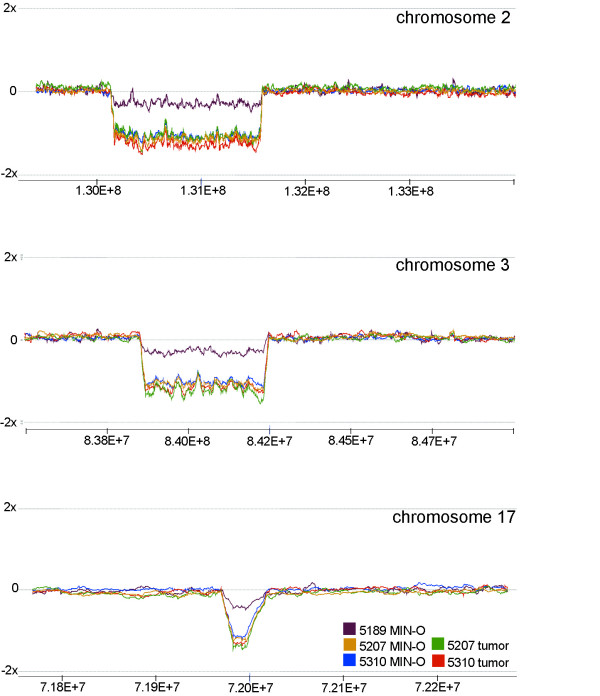
High resolution custom CGH microarray data on selected regions on chromosomes 2, 3 and 17. Small deletions in 2F, 3E, and 17E in MIN-Os and tumors from the 8w-D line were confirmed with the custom designed "zoom-in" array with average spacing of 547 bp. The specific breakpoints were determined as follows: chr2:130,621,986-131,735,939, chr3:83,909,586-84,292,657, chr17:72,077,340-72,137,044.